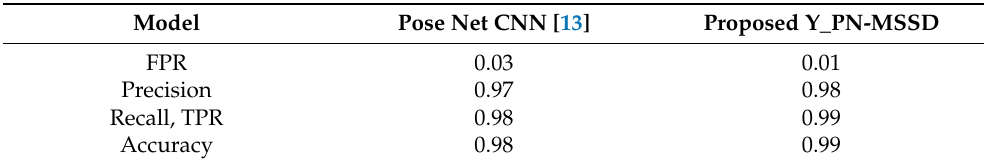
Table 4. The confusion metrics of the proposed model (Y_PN-MSSD) and existing model (Pose-Net CNN).